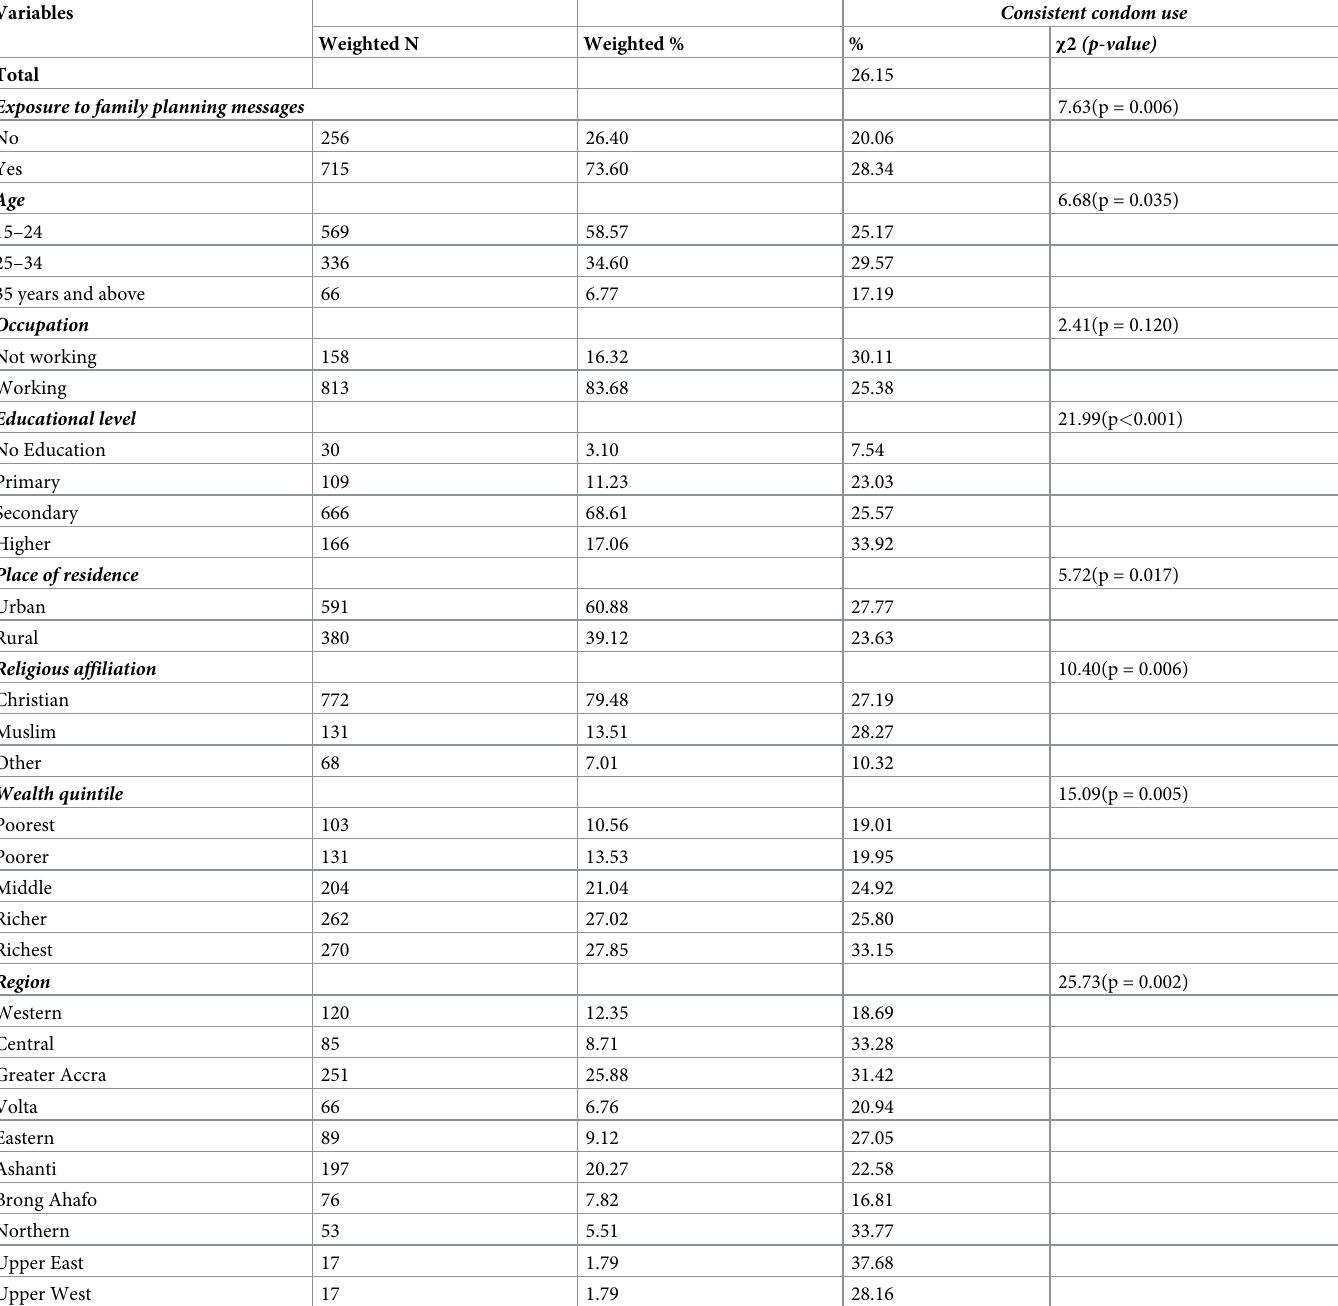
Table 1. Exposure to family planning messages, socio-demographic factors and consistent condom use among sexually active never married men in Ghana.